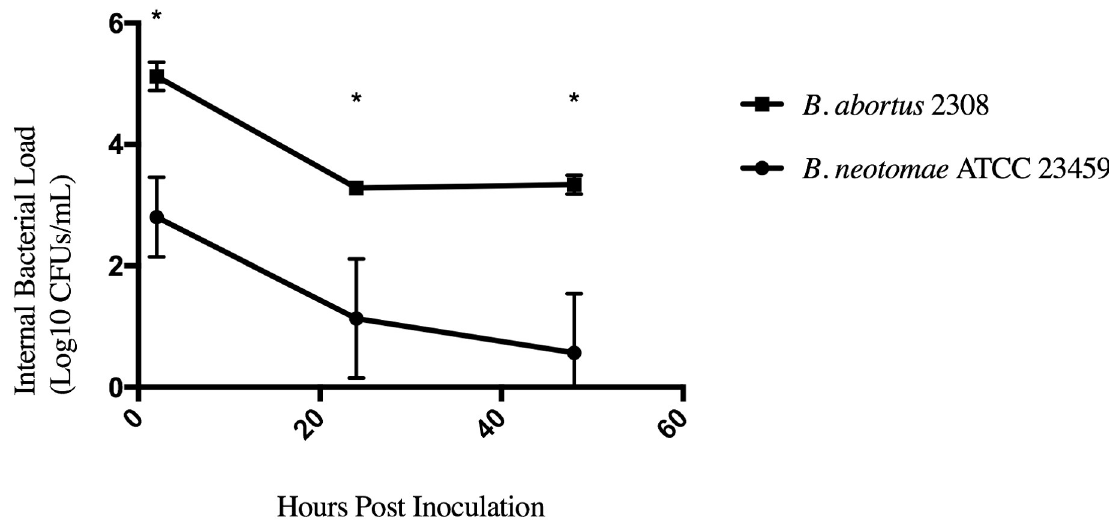
Fig 2. Intracellular survival of B . abortus 2308 versus B . neotomae ATCC 23459 in na ï ve murine macrophages. The na ï ve murine peritoneal macrophages were infected as described above and represent the internal bacterial CFUs of BN and B . abortus 2308 over 48hrs. Error bars represent the standard error, and � represent species tested that differ from BN, p < 0.05. Each indicator corresponds to the mean of three replicate wells from one assay.